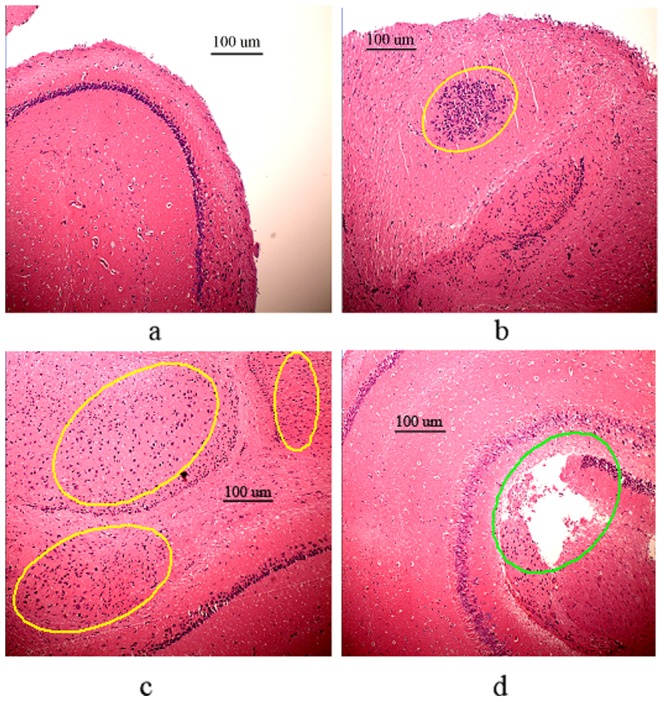
Histopathology of the hippocampus in mice following nasal administration of TiO2 NPs for 90 consecutive days.(a) Control group shows normal architecture of the hippocampus; (b) The 2.5 mg/kg bw TiO2 NPs treated group shows significant proliferation of all glial cells (yellow circle); (c) The 5 mg/kg bw TiO2 NPs treated group shows significant proliferation of all glial cells (yellow circle); (d) The 10 mg/kg bw TiO2 NPs treated group shows neuron necrosis and abscission of perikaryon, shrinkage of cell volume, nuclear irregularity and cellular degeneration (green circle).